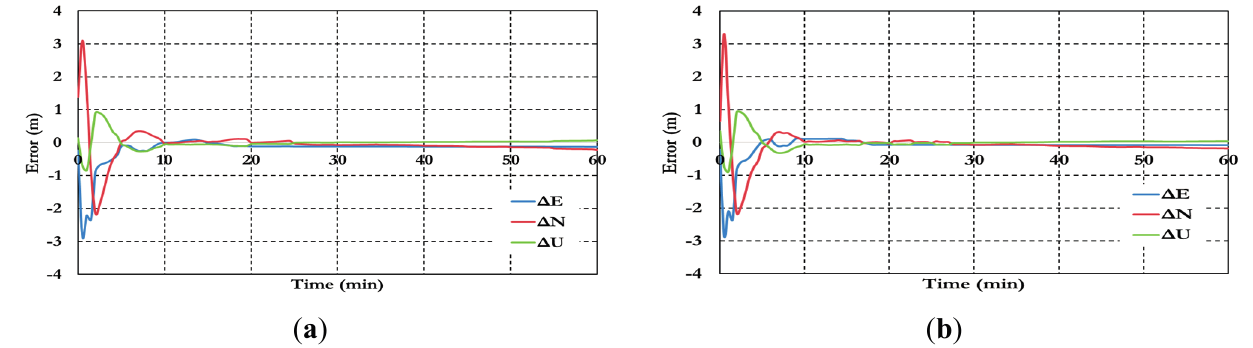
Figure 16. Positioning results of the BSSD PPP tight combination model using ( a ) GPS reference satellite; and ( b ) Galileo reference satellite